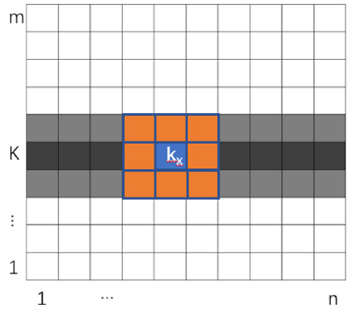
Figure 6. Cellular-neighborhood reading.